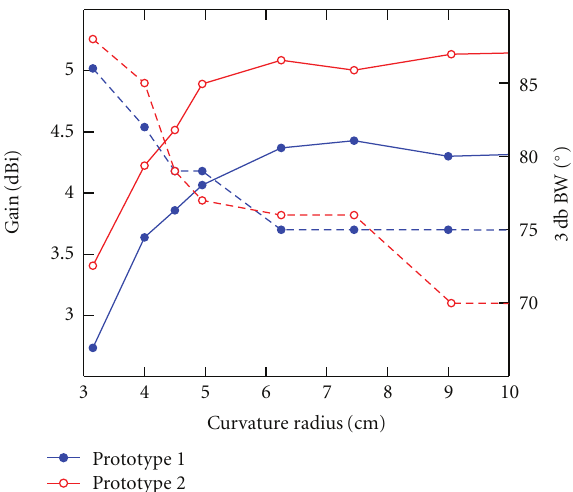
Figure 9: Measured gain and 3dB beamwidth of prototypes 1 and 2 when the antennas are bent in the W p direction. The solid lines indicate the gain along broadside, and the dashed lines show the 3dB